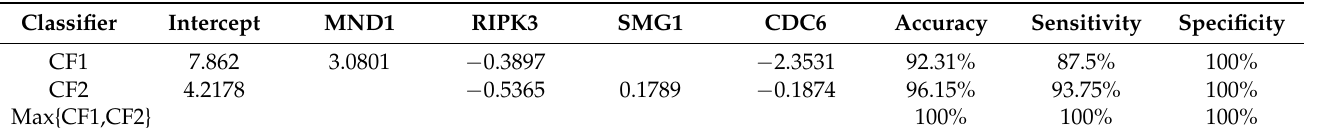
Table 13. GSE166253: Characteristics of the top-performing four-gene classifier. CF1 and CF2 are the first and second individual classifiers for data of COVID-19 patients vs. healthy controls.